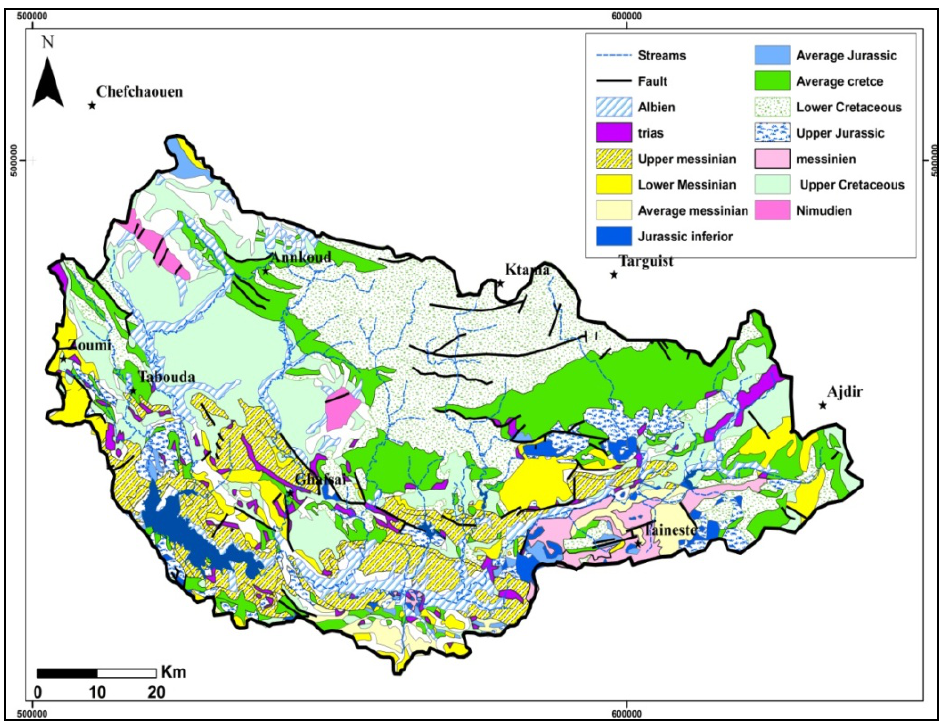
Figure 1 . Geological map of the Ouergha